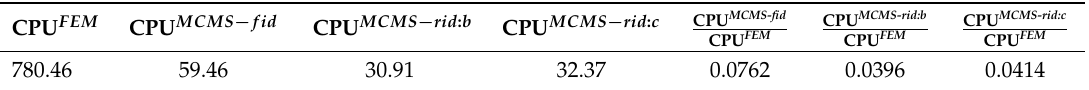
Table 6. Comparison of CPU time (s).